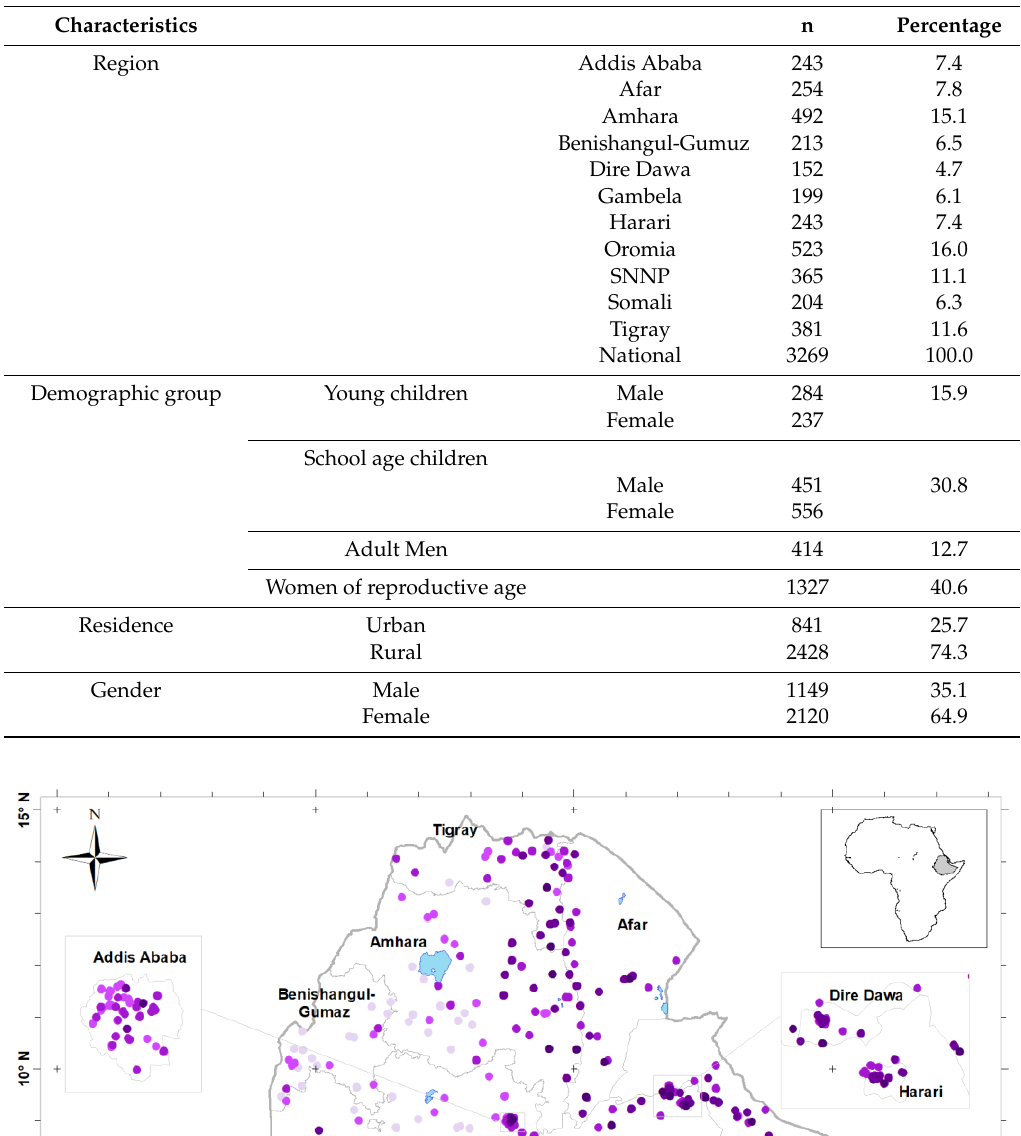
Table 2. Serum Se concentrations and prevalence of deficiency by region and demographic group in the Ethiopian National Micronutrient Survey, 2015.